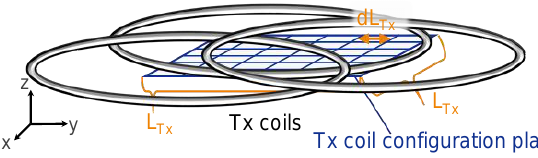
Figure 4. Transmission (Tx) coil configuration